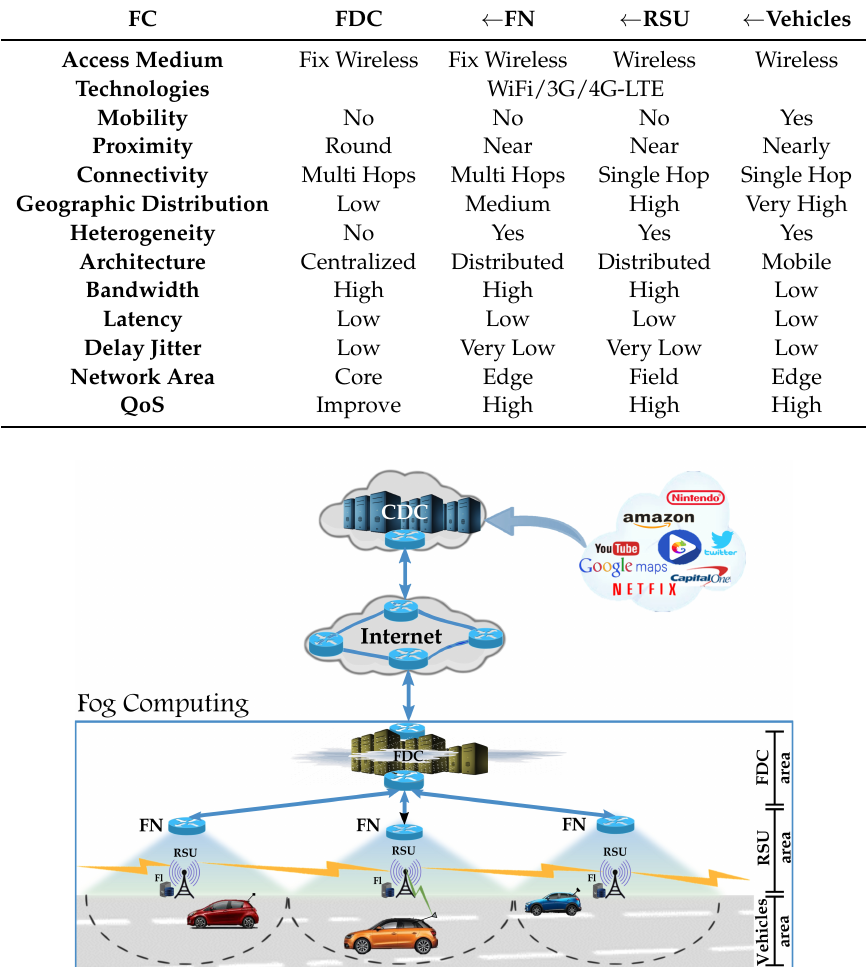
Table 1. Main characteristics for vehicular Fog computing.